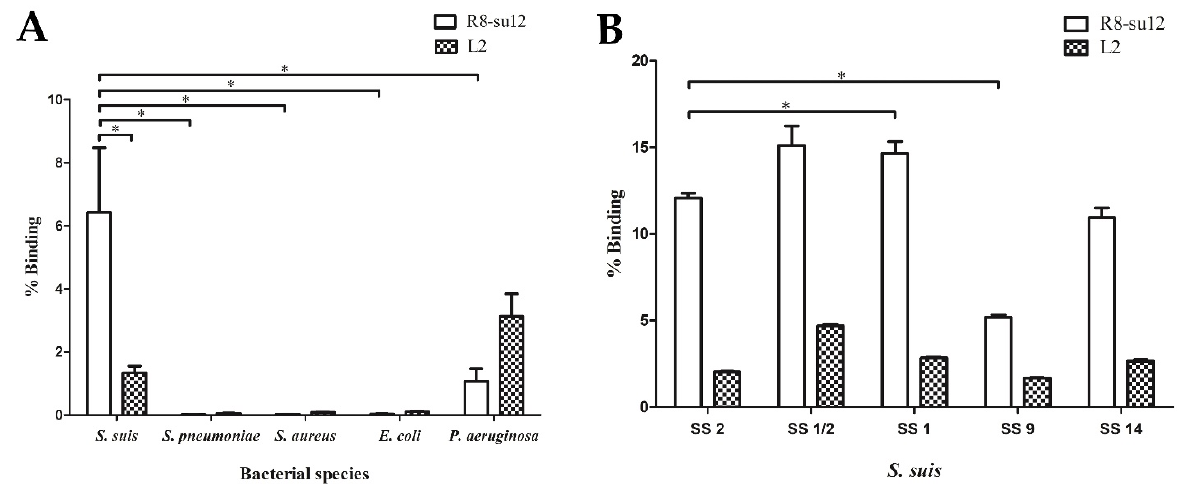
Figure 3. Specificity of the R8-su12 RNA aptamer . ( A ) The specificity of R8-su12 RNA aptamer was tested using target S. suis SS 2, P1/7 and non-target cells. ( B ) The specificity of R8-su12 RNA aptamer was tested using target S. suis SS 2, P1/7 and other S. suis serotypes. * indicates a statistically significant difference using a Mann–Whitney U test ( p < 0.05).